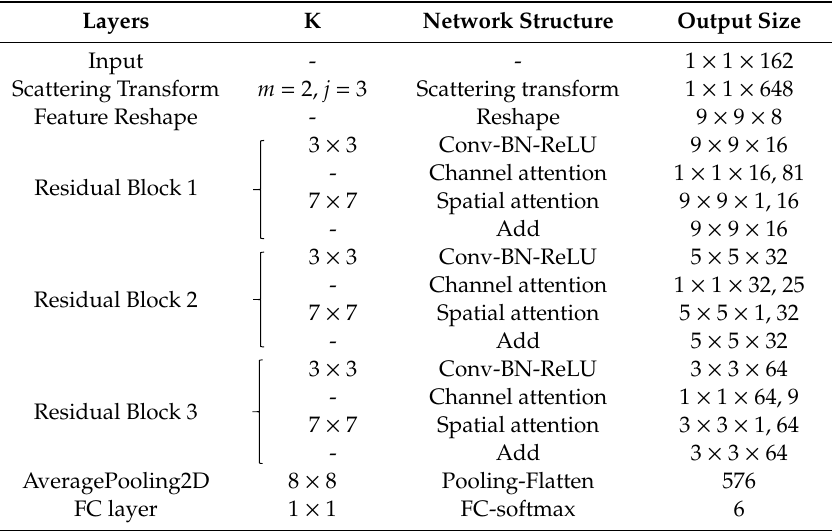
Table 2. Architecture details of the proposed ARNST for the Urban dataset.